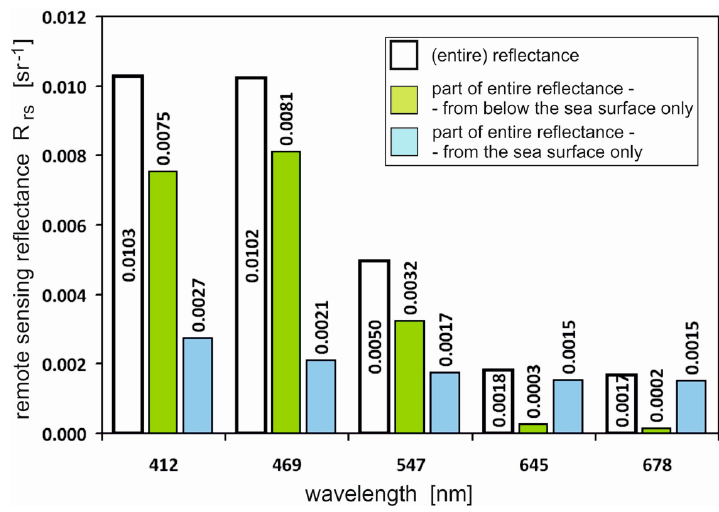
Figure 5. Reflectance of the sea area for various wavelengths (white bars) in the distribution of a light stream coming from a water column (green bars) and from the sea surface (blue bars).